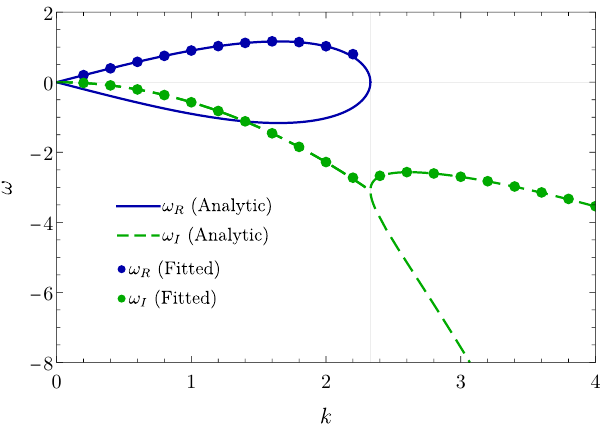
Figure 17 . Values of the real (blue) and imaginary (green) parts of the quasinormal sound fre- quency at q = 0 . 7 . The continuous lines correspond to the analytic prediction of (A.4), while 0 /ρ 0 the points mark the numerical values fitted from the code output. The charged silence threshold is highlighted by the vertical